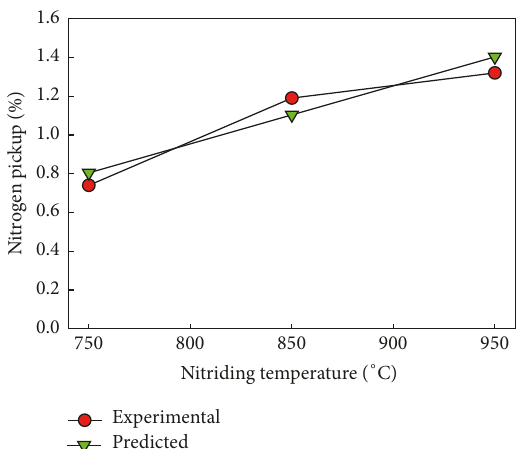
Figure 2: Variation between the predicted and published nitrogen pickup of high carbon (7.1%) ferromanganese at different nitriding temperatures